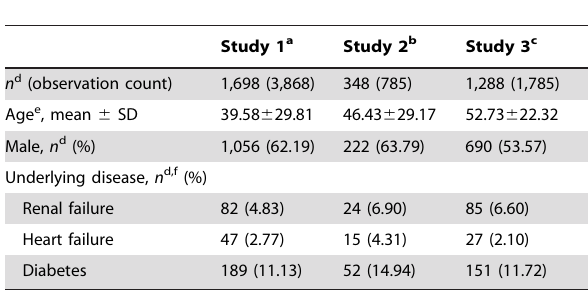
Table 1. Characteristics of the study